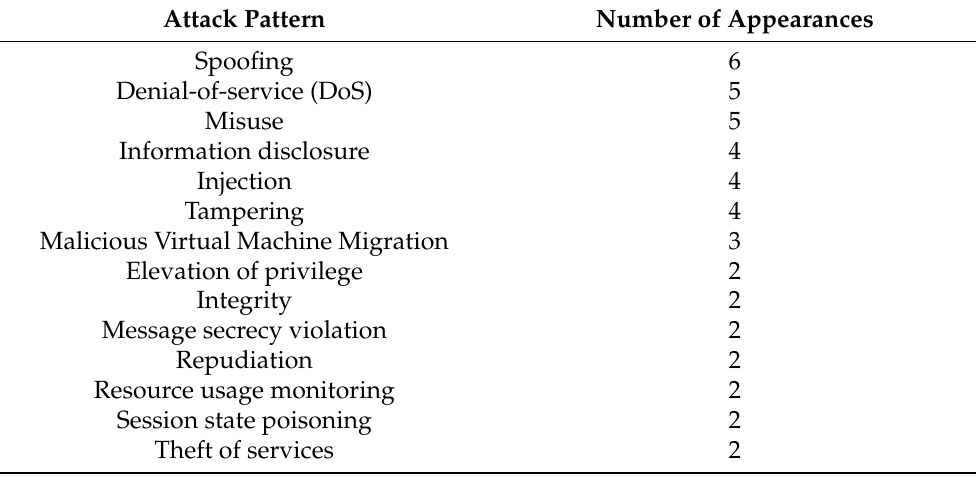
Table 3. Appearances of attack patterns in at least two papers (adopted from [247] with updates of numbers and